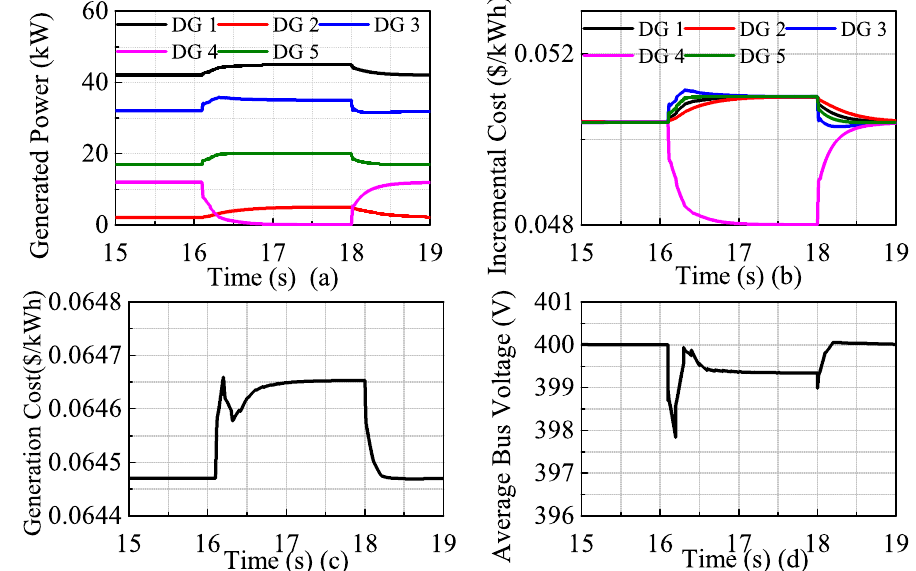
Figure 14. Performance of the proposed control strategy with an agent loss. ( a ) Generated power of each DG. ( b ) Incremental cost of each DG. ( c ) Total generation cost of all the DGs. ( d ) Average bus voltage of the